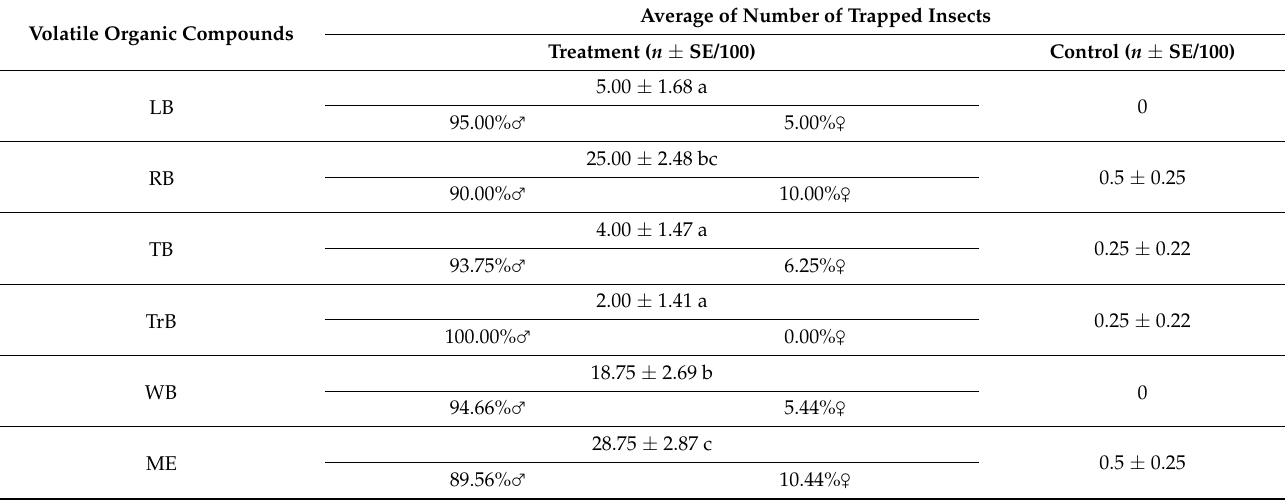
Table 3. The attractiveness of five essential oils and commercial fruit fly attractant to Oriental fruit flies.